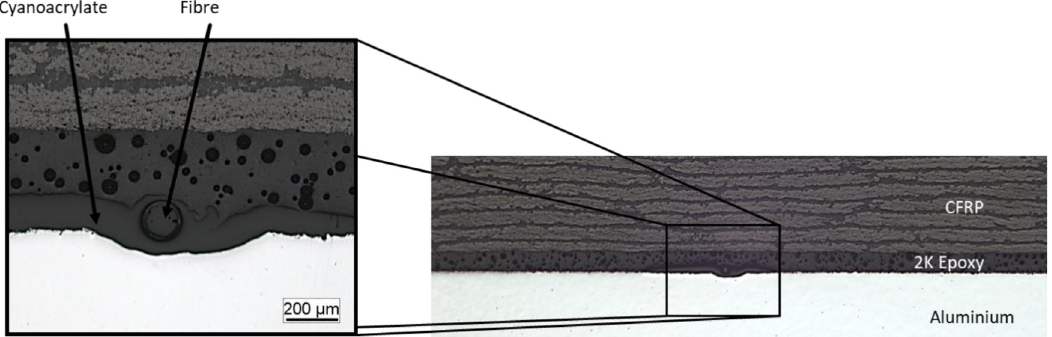
Fig. 3. Cross section of the fi nal specimen